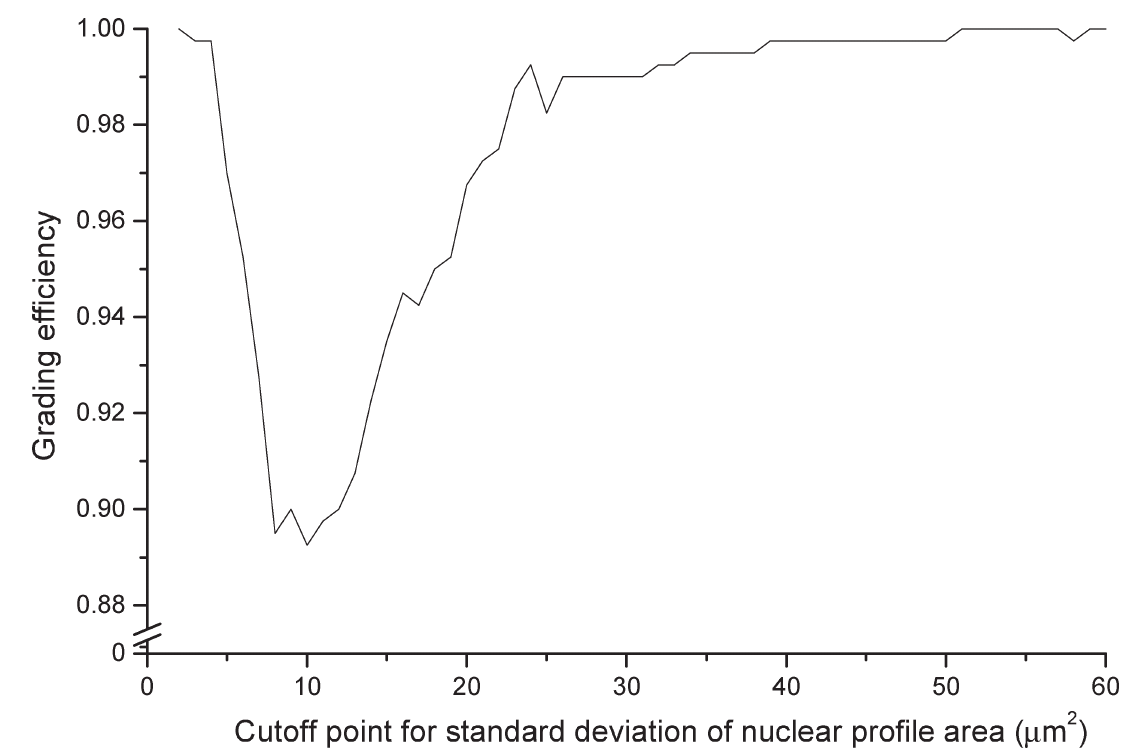
Fig. 4. The distribution of grading efficiencies (GE) for SD of nuclear profile area at different cutpoints. The minimum GE is 0.89 at the cutoff of 10 µ m 2 .